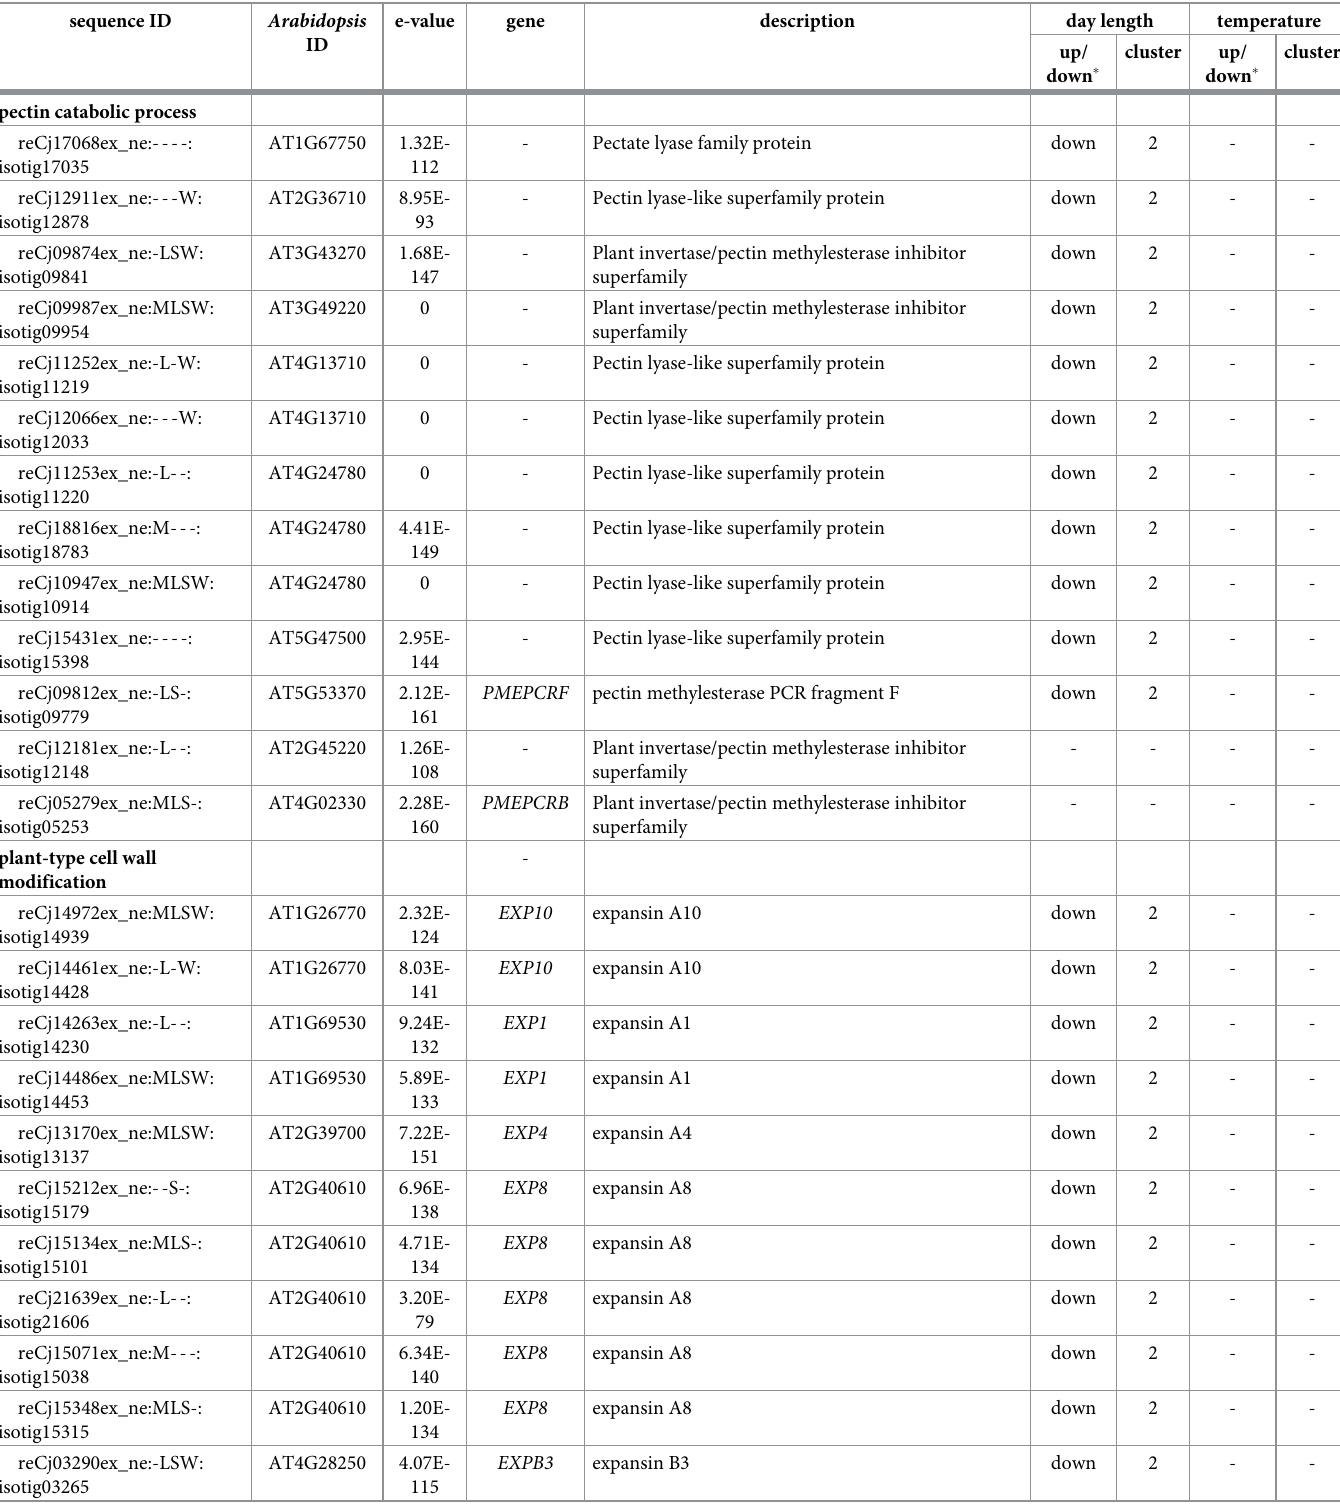
Table 4. Cell wall-related genes and effects of day length and